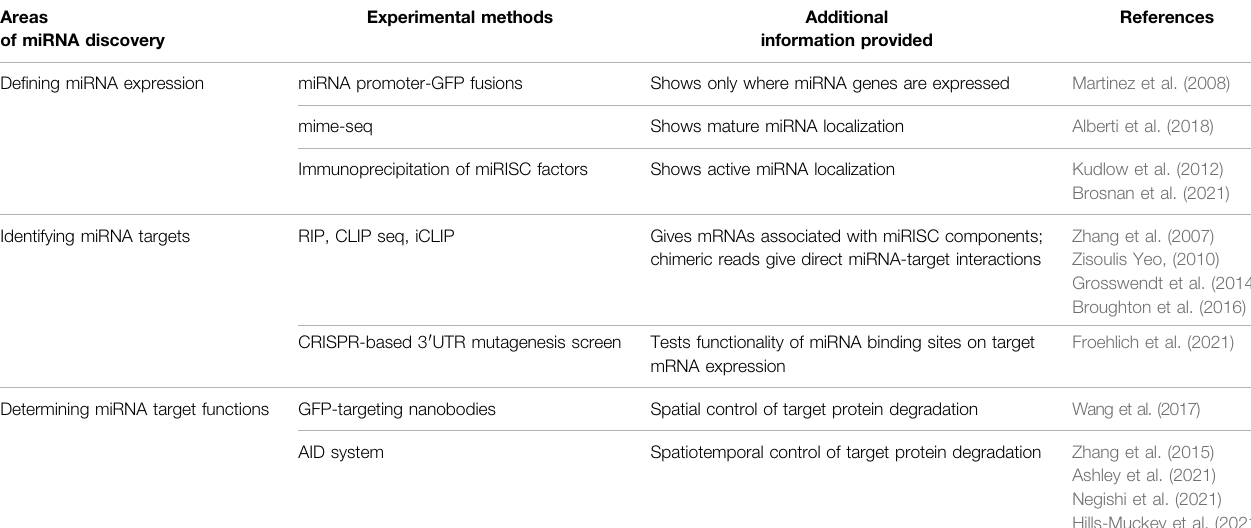
TABLE 1 | Summary of the methods for elucidating miRNA expression and function that are reviewed in the text. Areas of miRNA